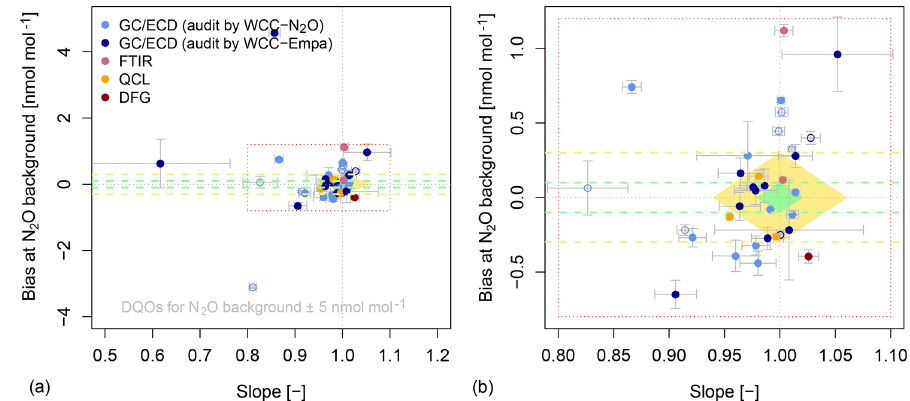
Figure 4. (a) N 2 O bias in the centre of the relevant ambient-air amount fraction (Table 2) vs. the slope of the audit for individual travelling standard comparisons. Different colours indicate different measurement techniques of the station analysers. Filled symbols refer to a compar- ison with the same calibration scale at the station and the WCC, while open symbols indicate a scale difference. The error bars correspond to the uncertainty of the slope and the bias (1 σ ). The green and yellow areas correspond to the WMO/GAW network compatibility and extended network compatibility goals for the range of ± 5nmolmol − 1 around the centre of the relevant amount fraction range, and the dashed green and yellow lines show the limits at the relevant amount fraction. (b) Detail of the red dotted box in (a) .